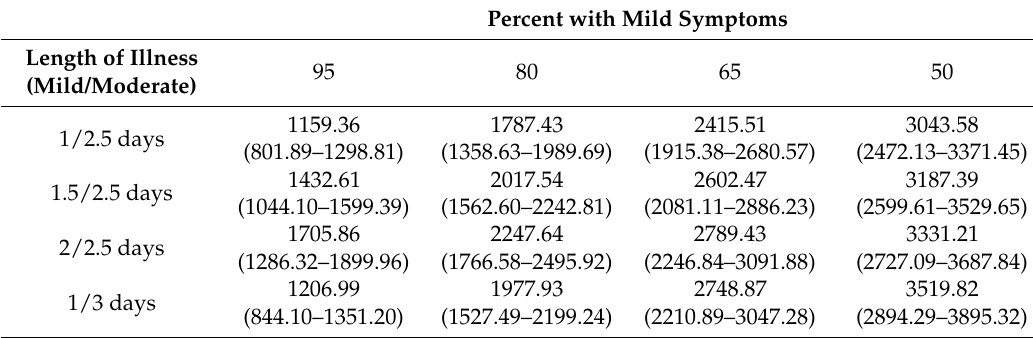
Table 1. Estimates of disability-adjusted life years (DALYs) for norovirus infections with an annual incidence of 59/1000